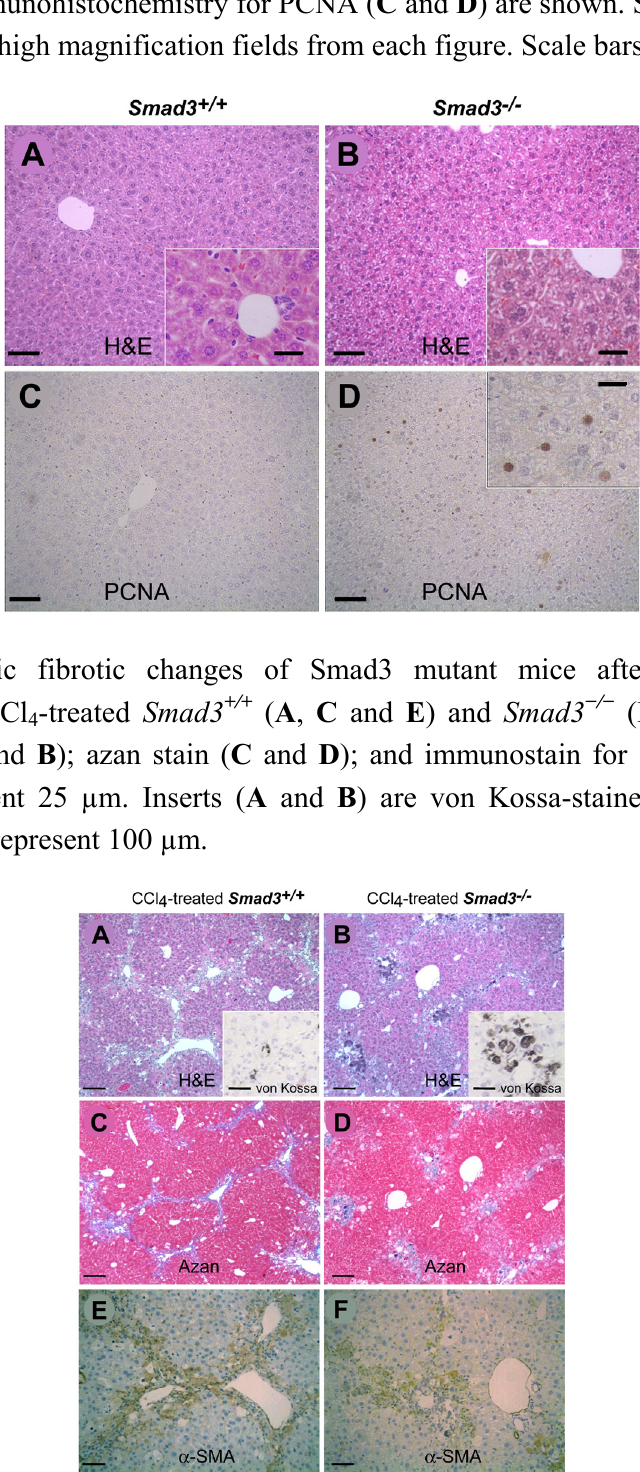
Figure 1. Histopathological analysis of livers from Smad3 +/+ and Smad3 −/− mice. Liver tissues from Smad3 +/+ ( A and C ) and Smad3 −/− ( B and D ) mice. Results for H & E staining ( A and B ) and immunohistochemistry for PCNA ( C and D ) are shown. Scale bars represent